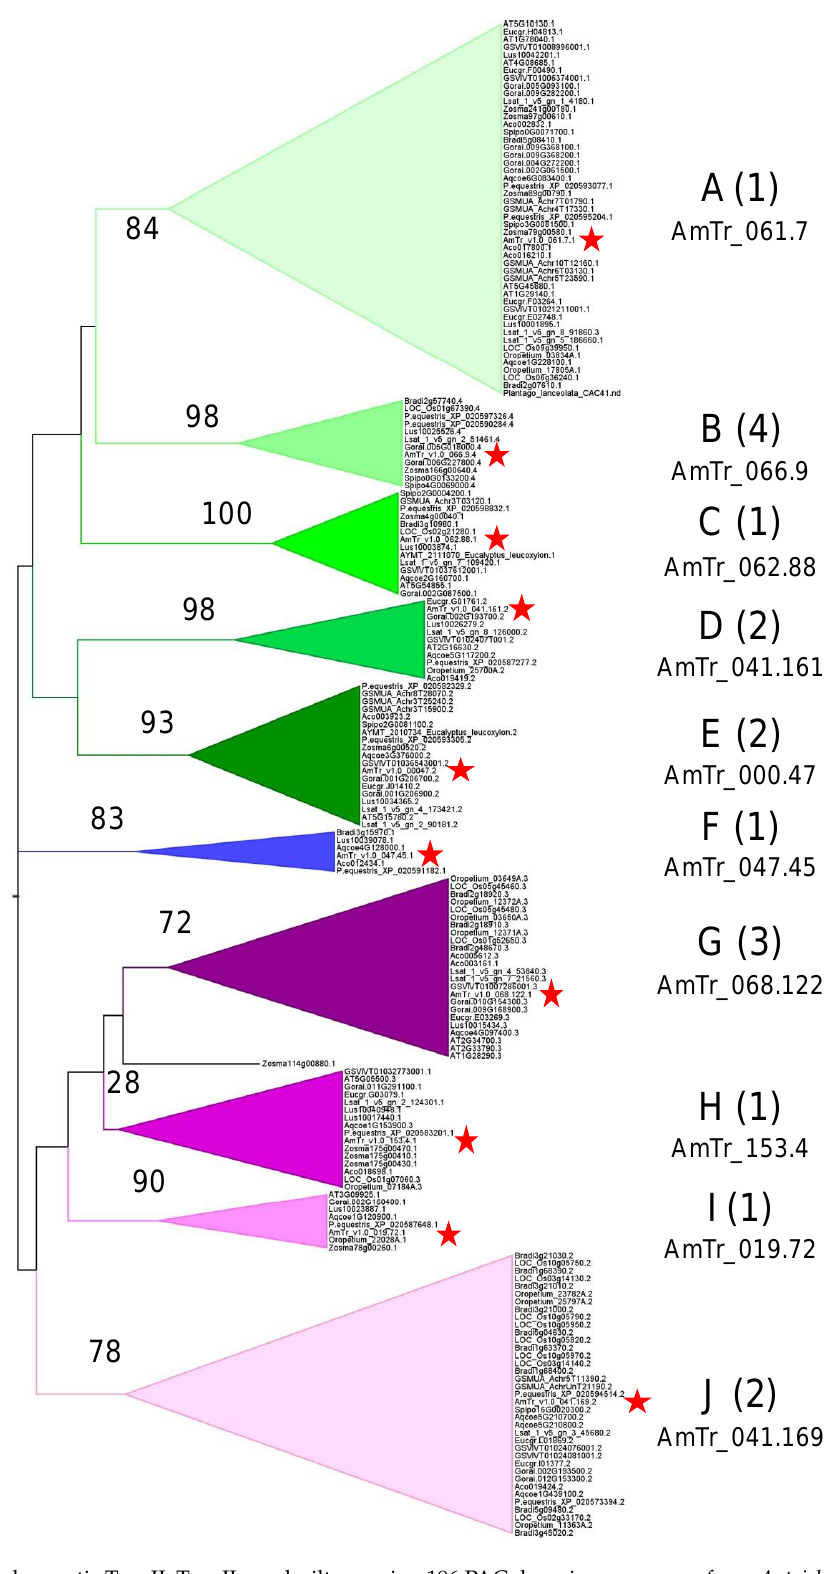
Figure 6. Phylogenetic Tree II. Tree II was built up using 196 PAC domains sequences from A. trichopoda to A. thaliana . Ten clades (A to I) were defined according to significant bootstrap values (higher than 72, with the exception of clade B). The type of PDPs (e.g., Type 1 is 1, see Figure 2) found in each clade indicated between brackets. The name of the A. trichopoda PDP found in each clade is indicated and highlighted with a red star.